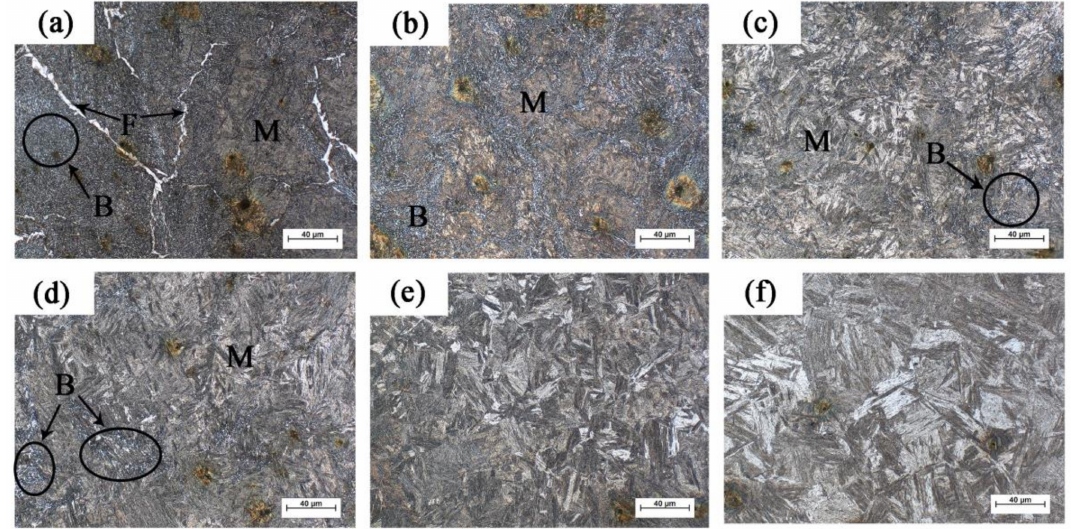
Figure 5. Microstructure of VL steel fractured at 600~1200 ◦ C with a higher strain rate of 10 s − 1